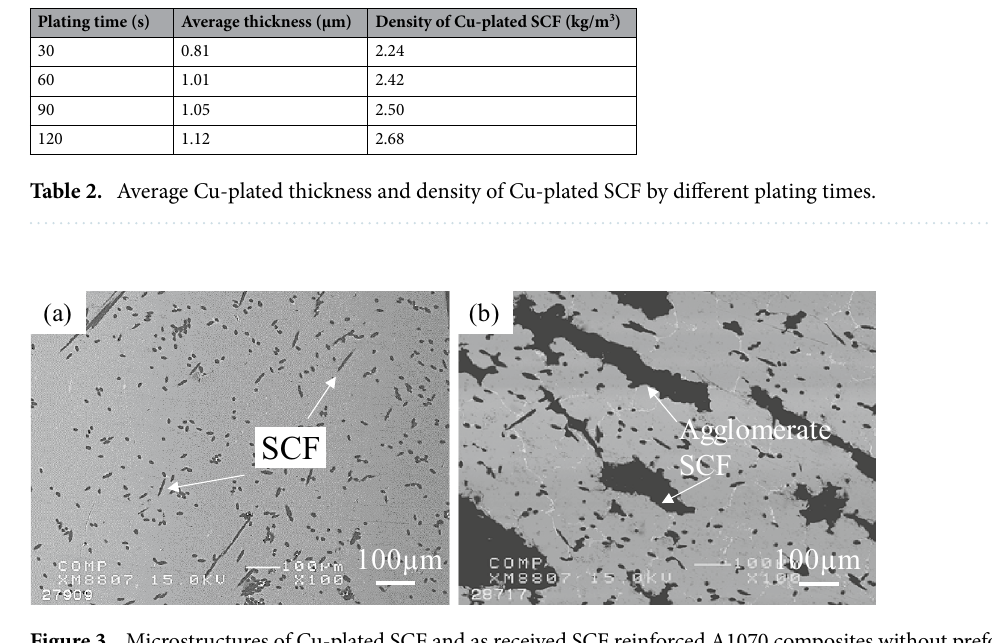
Figure 2. SEM images of ( a ) as-received SCF, ( b ) Cu-plated SCF, 30 s, ( c ) Cu-plated SCF(60 s), ( d ) Cu-plated SCF, 90 s, and ( e ) Cu-plated SCF, 120 s. Plating time (s)